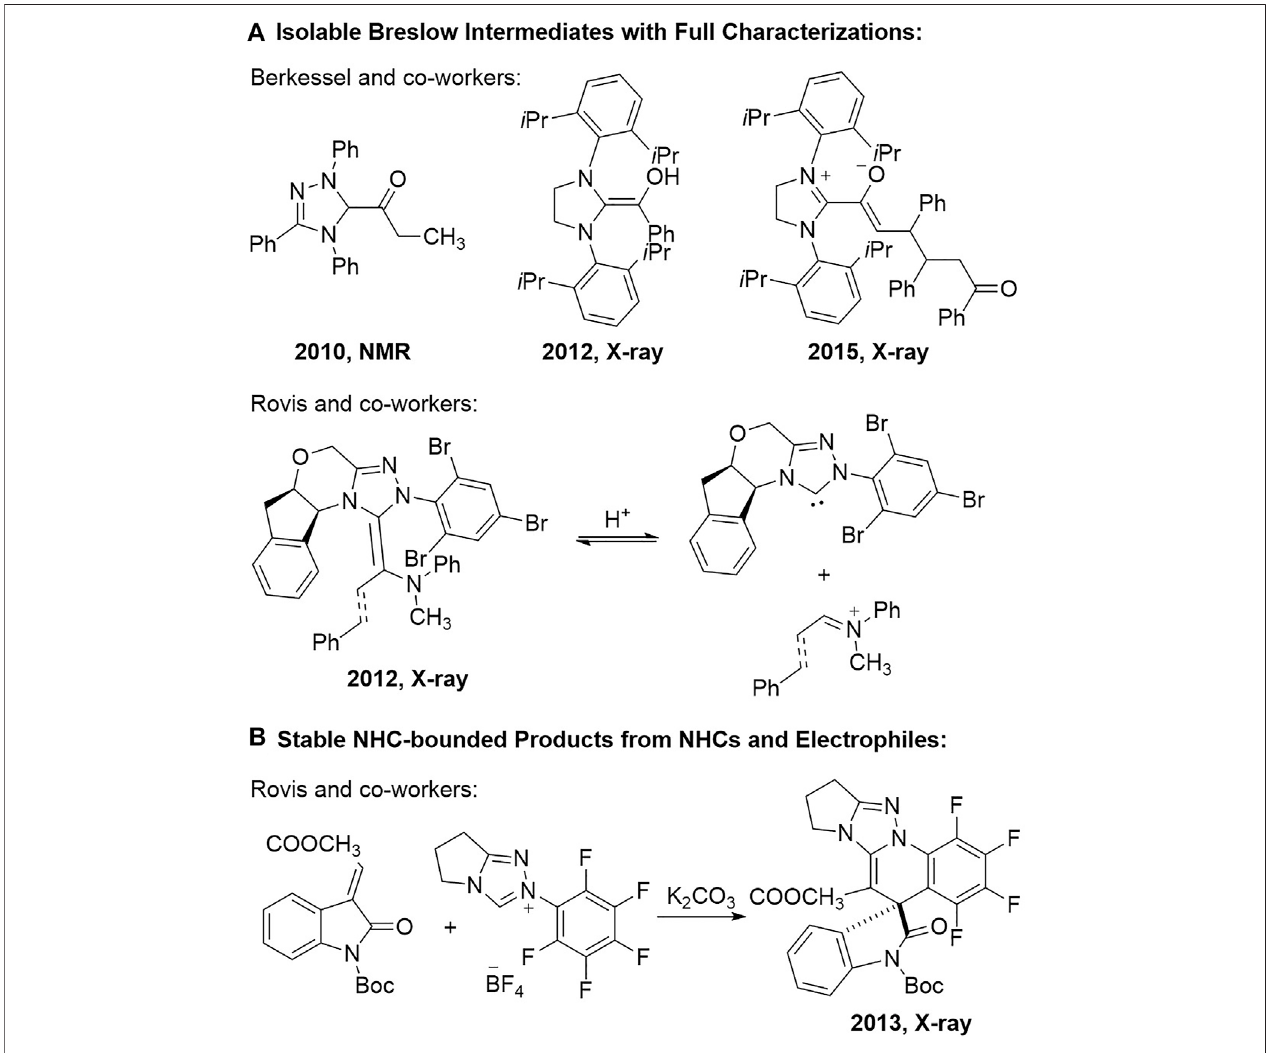
FIGURE 1 | Isolation and characterization of NHC-bounded intermediates and products. (A) Isolable breslow intermediates with full characterizations. (B) Stable NHC-bounded products from NHCs and electrophiles.